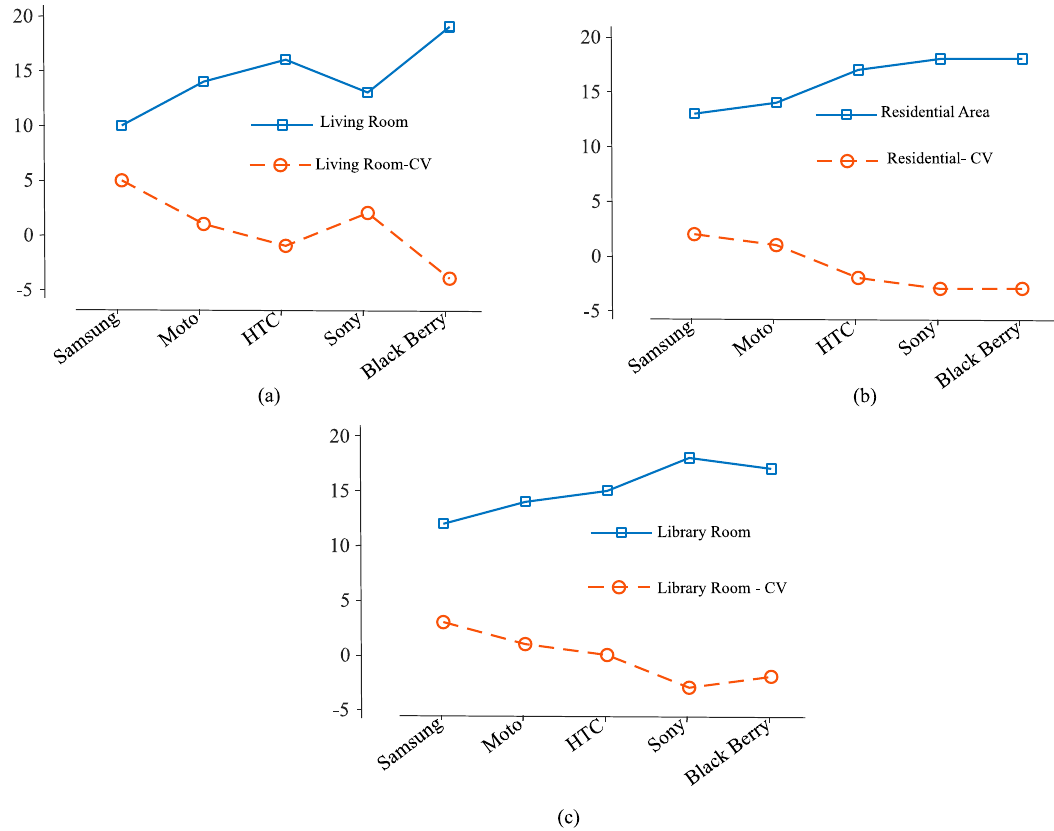
Figure 6. Decibel value of calibration process for ( a ) Living room; ( b ) residential area; ( c ) library.